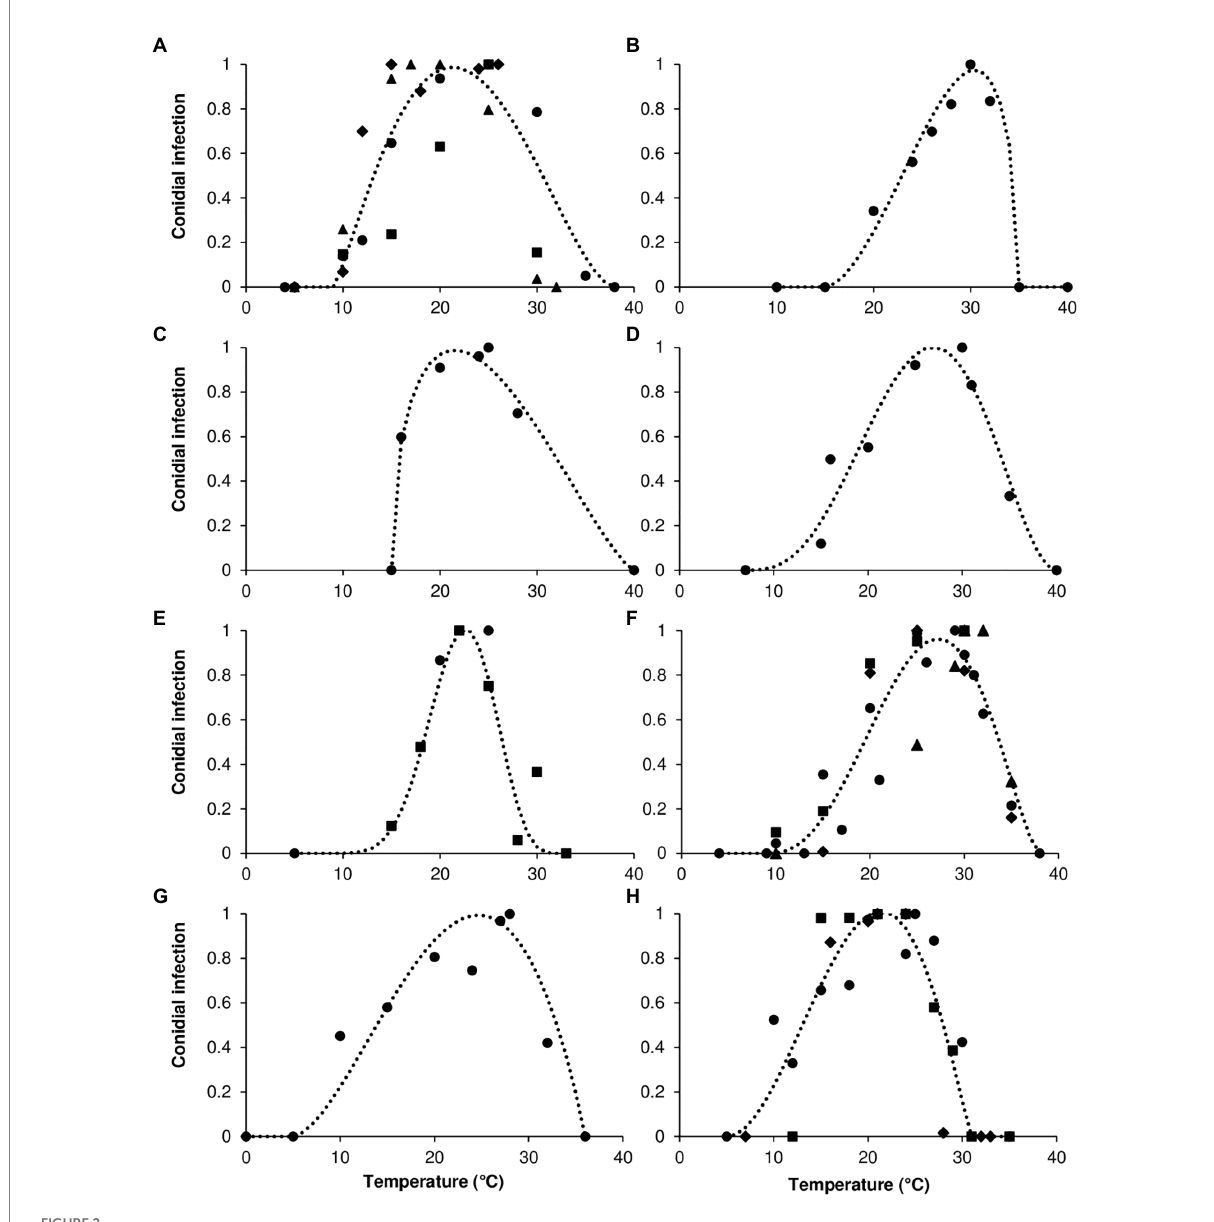
FIGURE 2 Infection by conidia for (A) acutatum, (B) graminicola, (C) destructivum, (D) coccodes, (E) dematium, (F) gloeosporioides, (G) truncatum, and (H) orbiculare clades. Symbols show the average conidial infection in (A) ● Colletotrichum acutatum , ■ C. godetiae , ♦ Cossonus lupini , ▲ C. simmondsii ; in (B) ● Chironomus graminicola ; in (C) ● C. lentis ; in (D) ● C. coccodes ; in (E) ● C. dematium , ■ C. spinaciae ; in (F) ● C. gloeosporioides , ■ C. fragariae , ♦ C. gossypii , ▲ C. musae ; in (G) ● C. capsici ; in (H) ● Carpolipum orbiculare , ■ C. trifolii , ♦ C. lindemuthianum . The dotted lines show the fit of data using a Bete Equation (1); equation parameters for each clade are summarized in Table